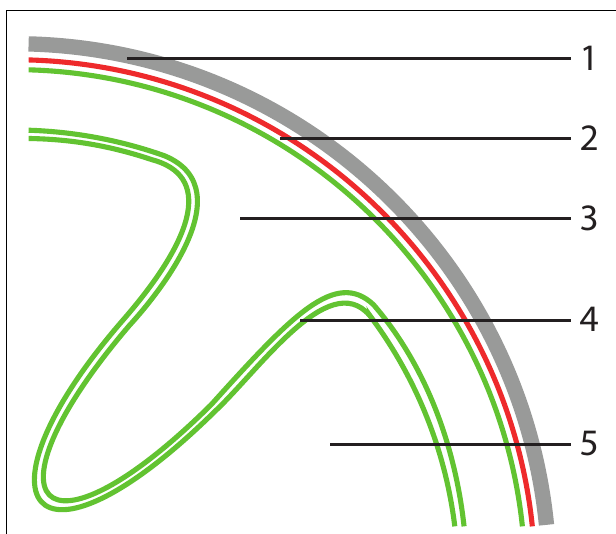
FIGURE 2 | Proposed model for Planctomycete cellular organization. (1) proteinaceous cell wall, (2) assymetric bilayer outer membrane, (3) periplasm, (4) phospholipid bilayer cytoplasmic membrane, (5) cytoplasm. In this model, the outermost membrane has characteristics of an outer membrane (OM), thus the outermost compartment is defined as a (potentially specialized) periplasm.The key feature, which sets Planctomycetes apart from normal Gram-negative Bacteria, of this proposed model is plasticity of the cytoplasmic membrane (CM). Due to lack of peptidoglycan, the CM is largely uncoupled from the other parts of the cell envelope that confer structural integrity, allowing folding as illustrated above.